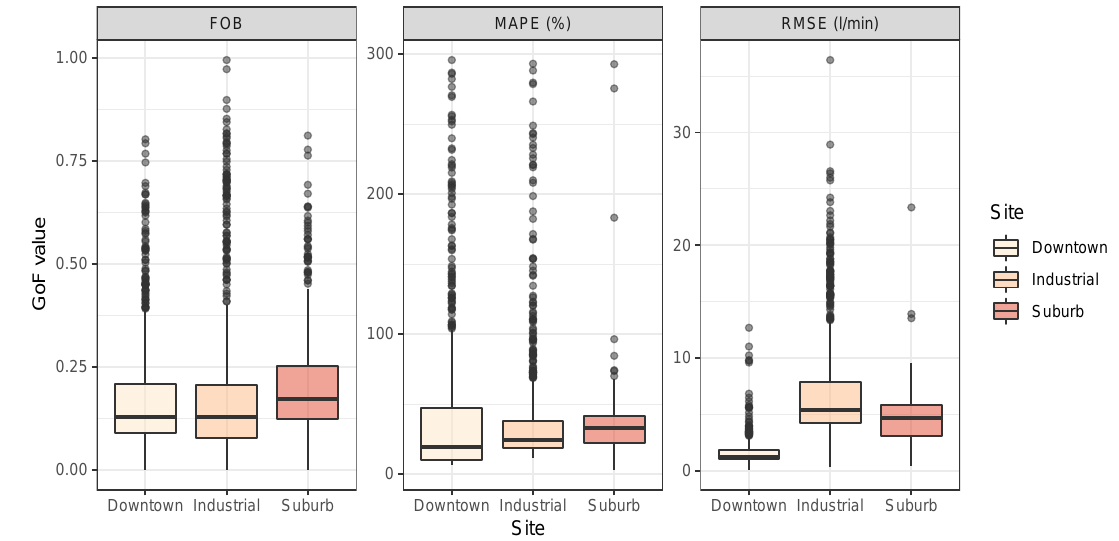
Figure 4. Distributions of the values of the goodness of fit parameters FOB, MAPE, and RMSE at the three site (downtown, industrial site, and suburb) over the entire period of study,